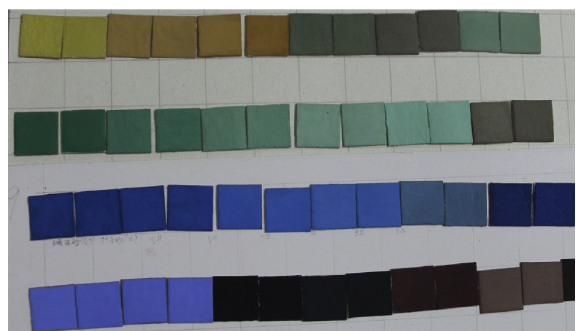
Figure 2: Part of the samples for spectral reference